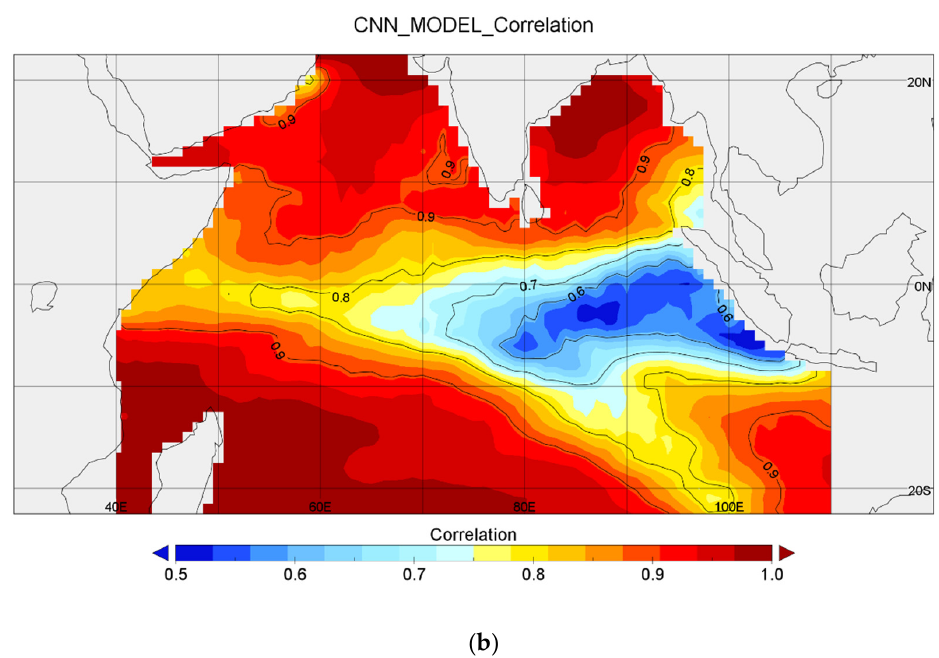
Figure 5. ( a ) Correlation between the TCN-predicted SST time series and the actual SST time series. ( b ) Correlation between the CNN model-predicted SST time series and the actual SST time series.